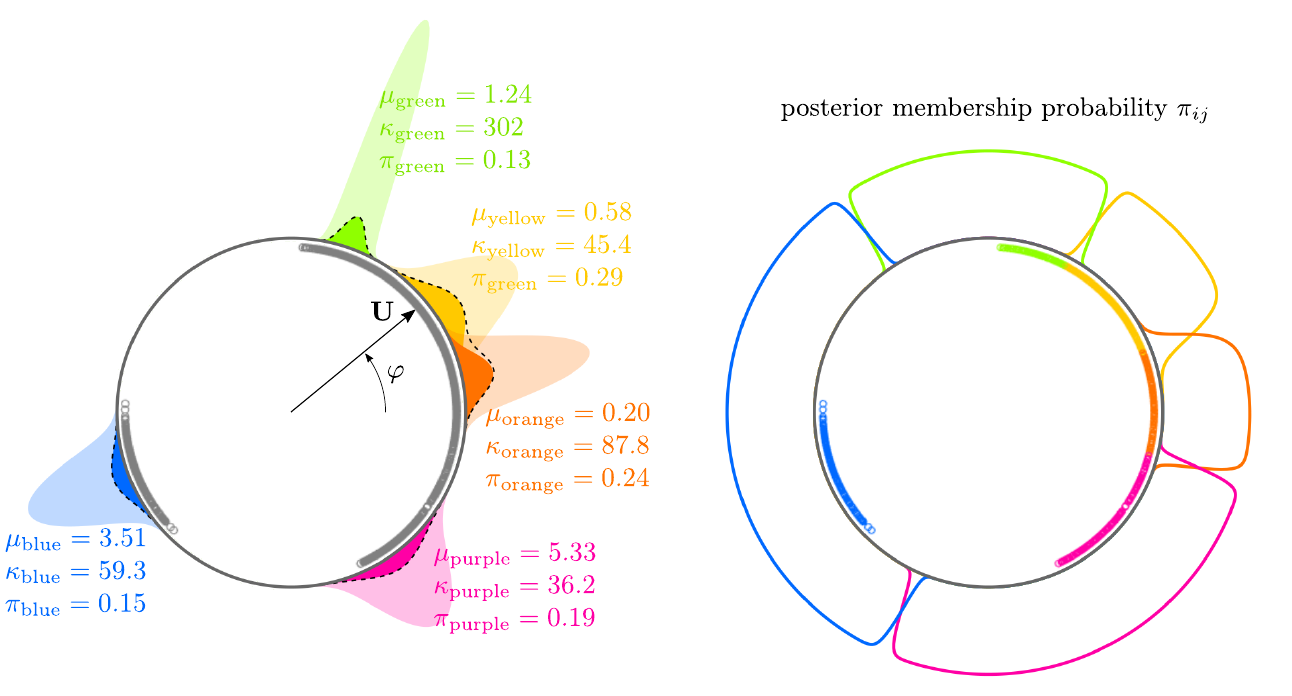
Figure 6. ( Left panel ) Hue distribution on the ‘wooden toys’ image (the density is the black dashed line), and its mod- eling with a mixture of 5 Von Mises distributions. We can check that π orange + π yellow + π green + π blue + π purple = 1. ( Right panel ) shows the posterior membership probability π ij (given by Bayes formula) that pixel i comes from component j